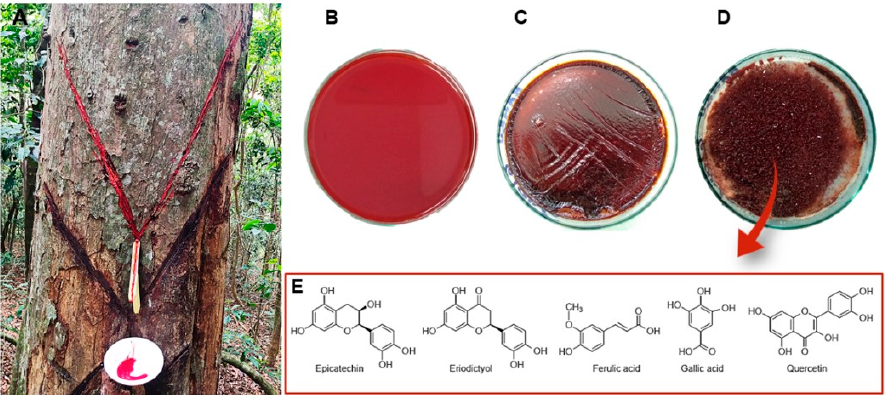
Figure 1. Virola oleifera in Espirito Santo, Brazil. The resin was collected from 0.5 cm-deep incisions in the tree trunk, as demonstrated in ( A ), and transferred into an amber glass vial ( B ). The fluid exudate was dried at 40 °C ( C ) and ground. Afterwards, the resin was sheltered from light at 4 °C until used as shown in ( D ). Previous chemical characterization by our research group revealed a high content of polyphenols, the main compounds demonstrated in ( E )